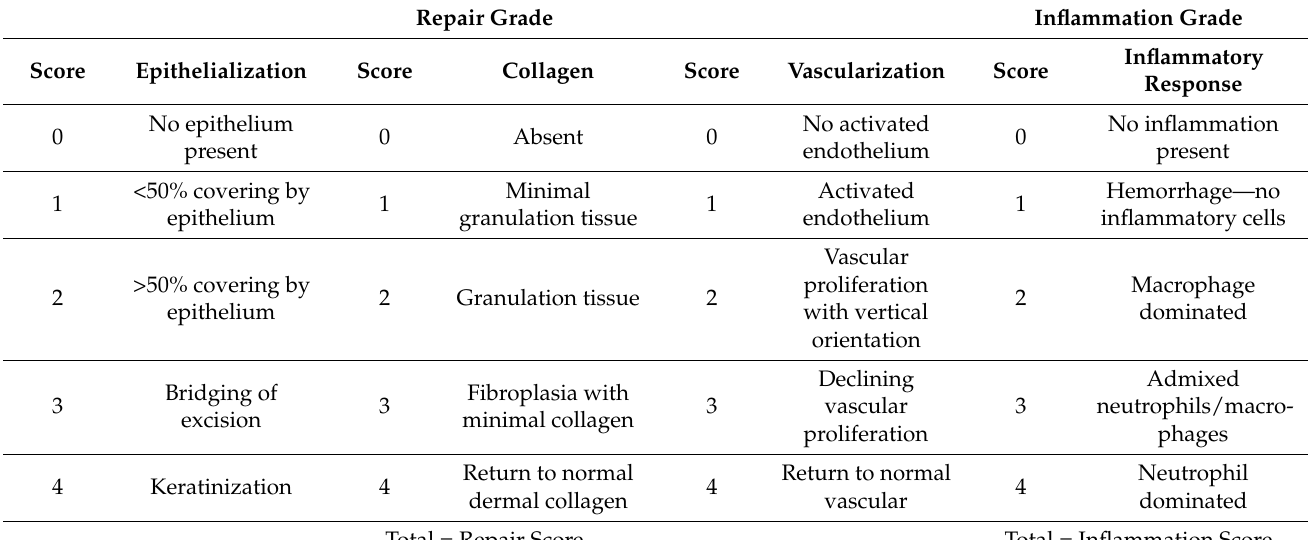
Table 1. Histologic repair and inflammation grading